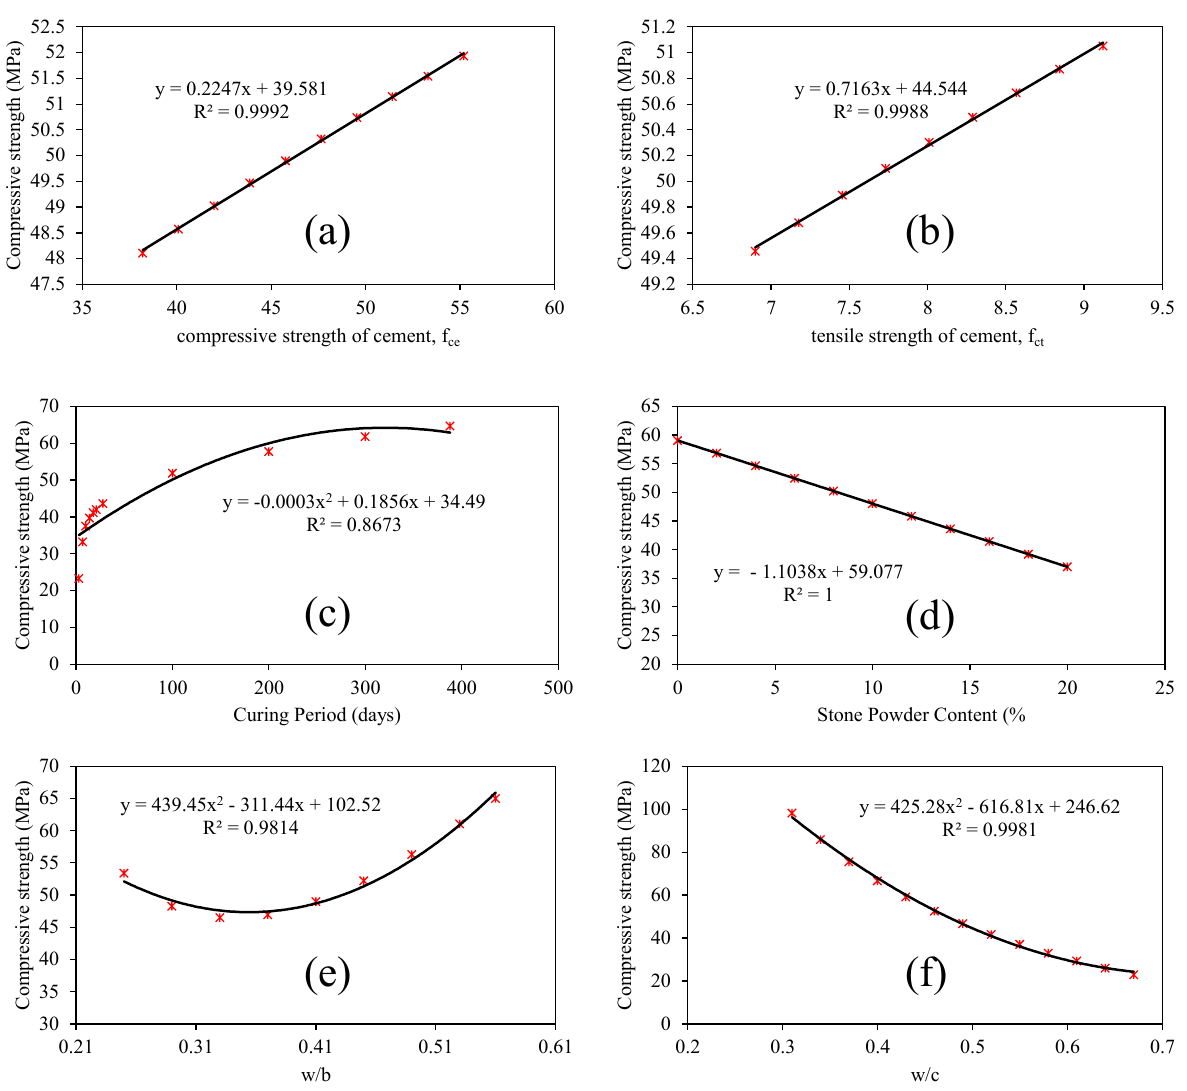
Figure 10. Sensitivity analysis of the developed model.